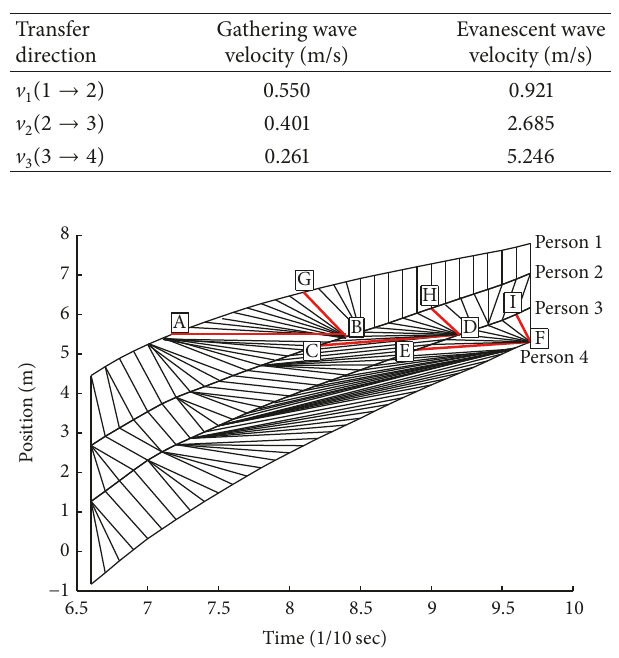
Table 3: Values of pedestrian shockwaves.